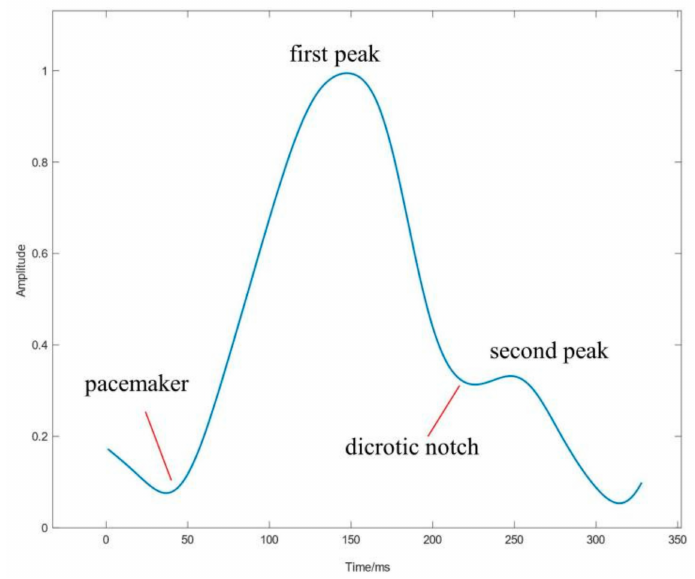
Figure 4. Typical PPG